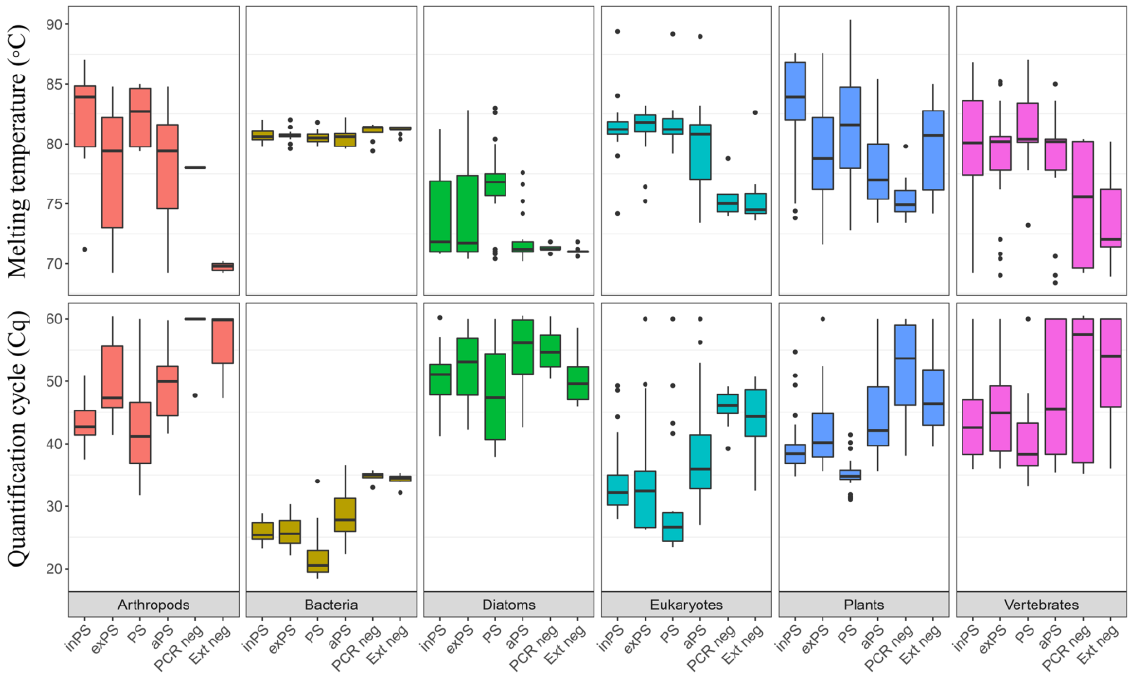
Figure A4. Overview of the qPCR results. In the bottom graphs the Cq values are summarized in box-plots, all the individual measurements are plotted over the box-plots on a lighter color, points with same color as the box plot are outliers ( n = 28 for all extraction methods, except for plants, n = 42, PCR negatives n = 8, and extraction negatives n = 10). The top graphs show the melting temperature for each Cq in the bottom graph (if multiple peaks were observed the highest intensity was considered). For each of the six biological groups studied, the extraction protocol are listed as: (i) unmodified PowerSoil kit protocol (PS protocol) (ii) modified PowerSoil kit protocol using Andersen’s lysis buffer (aPS protocol) (iii) Powersoil protocol coupled with Phosphate Buffer to extract the extracellular (exPS protocol) and intracellular DNA (inPS protocol) fractions. PCR neg and Ext neg correspond to PCR negatives n = 8, and extraction negatives n = 10. Table A6. Overview of the sediment sample used in this